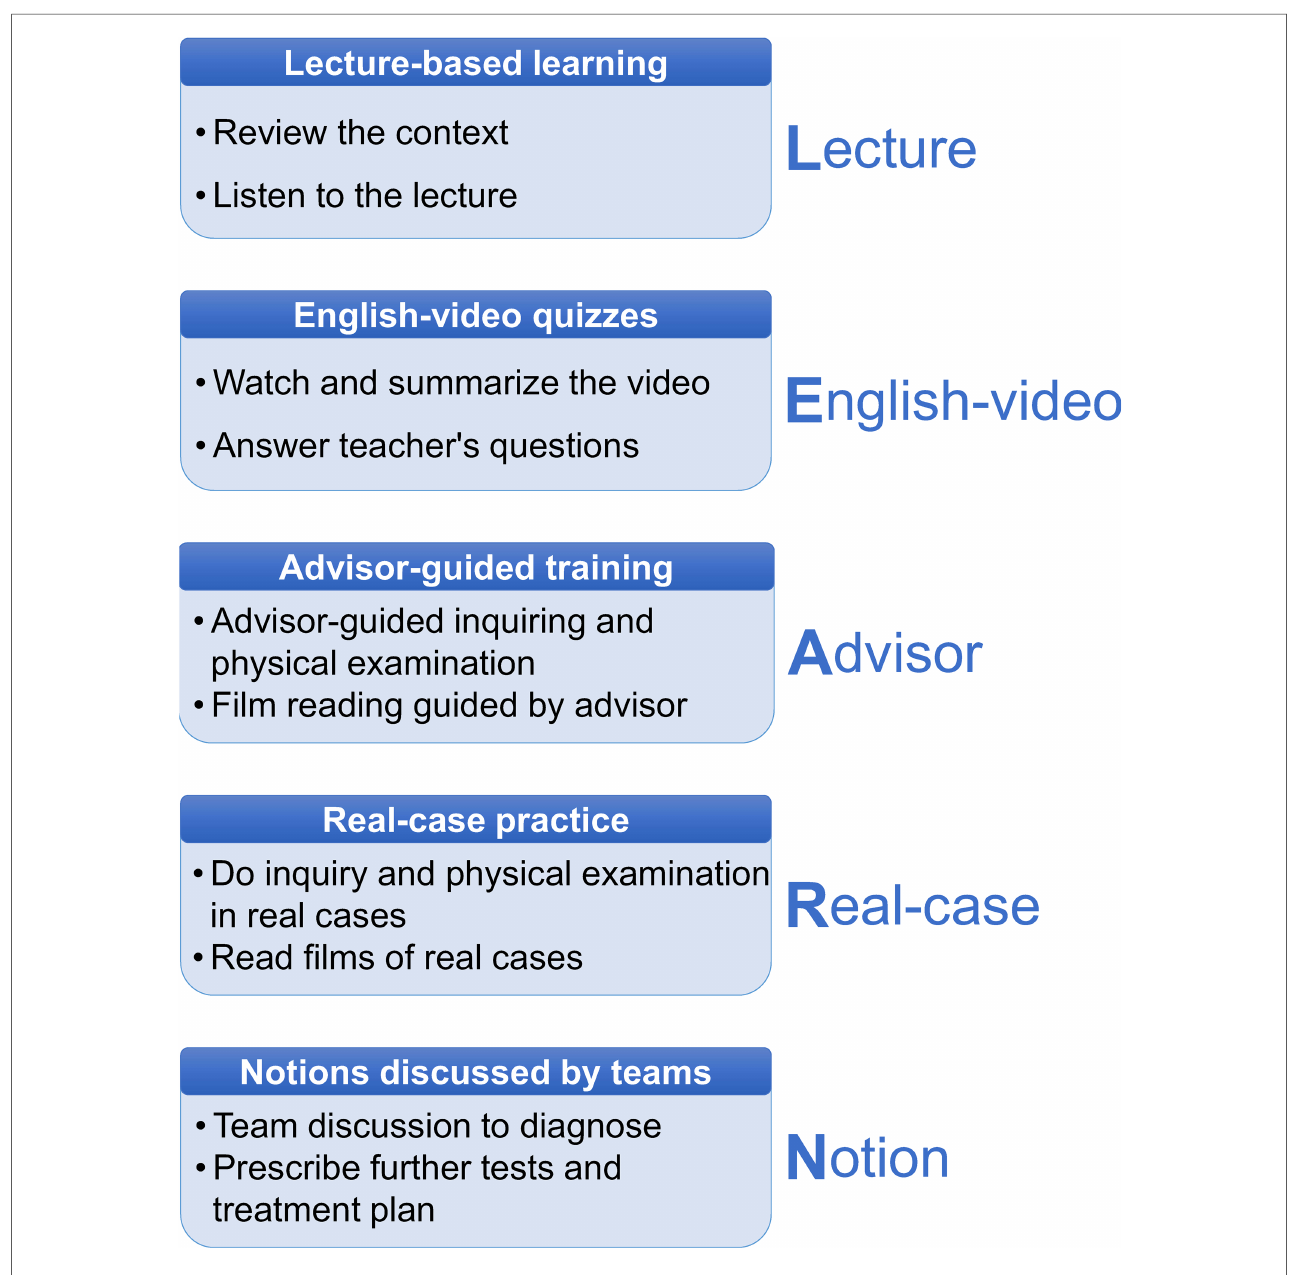
FIGURE 1 The process of LEARN